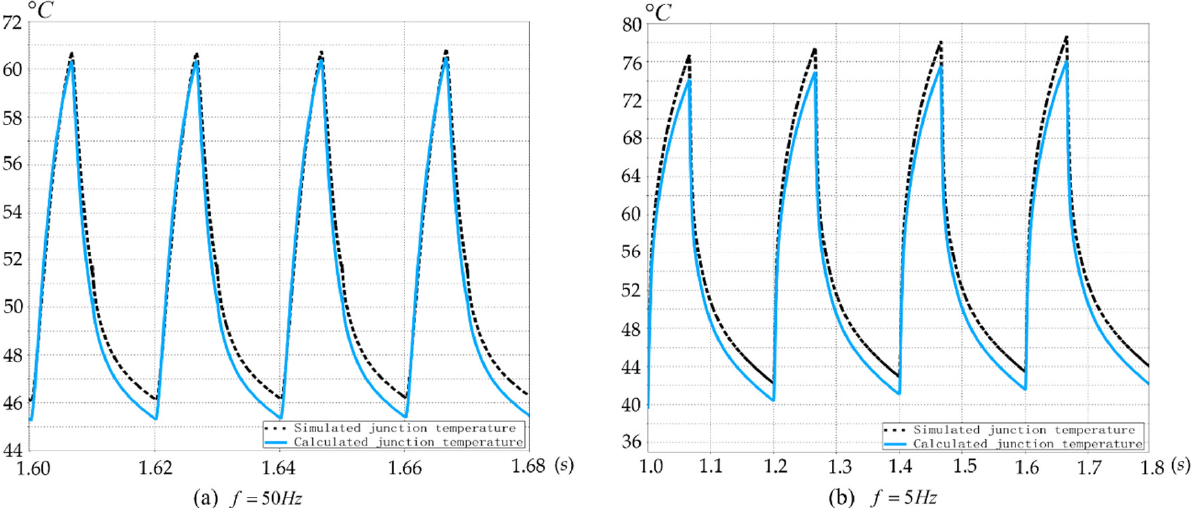
Figure 2. Three-phase inverter circuit.